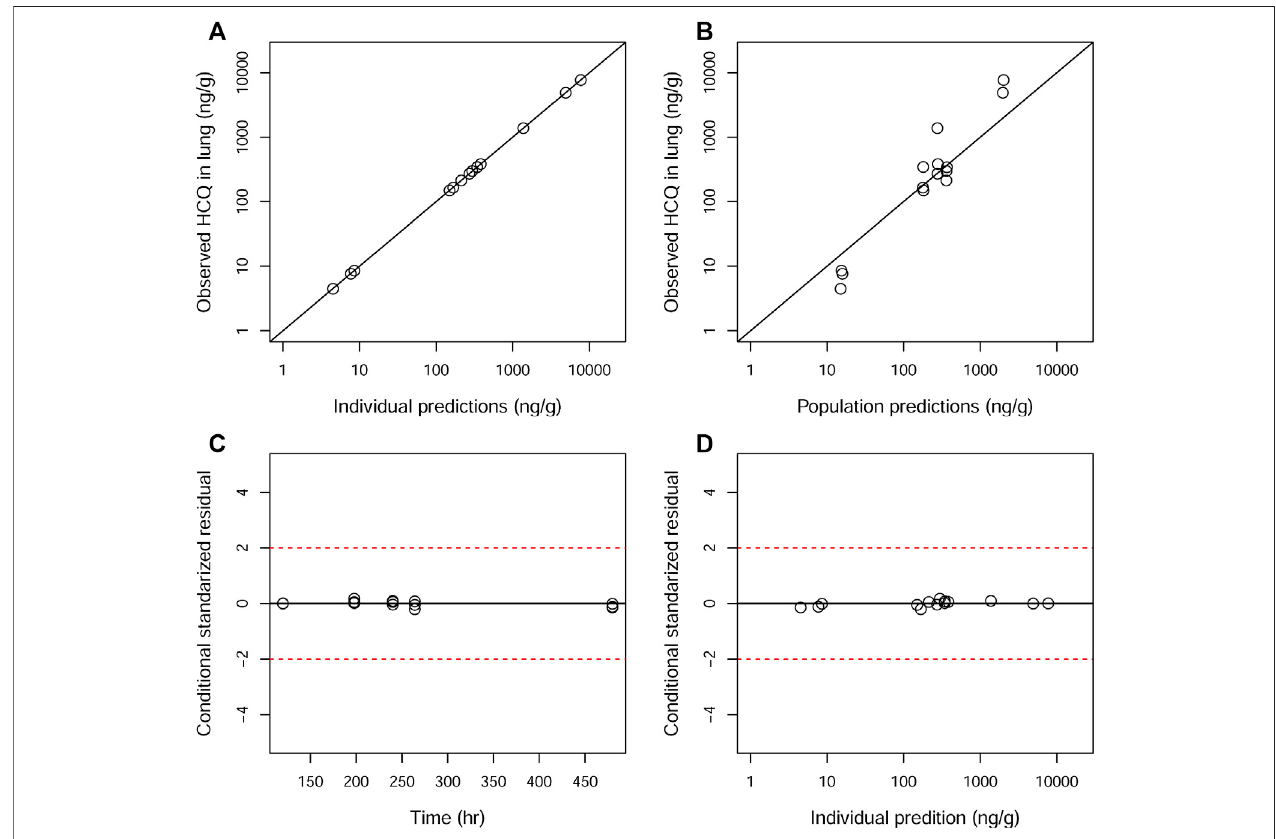
FIGURE5| Goodness-of- fi tplotsofthelungforthe fi nalmodel.Thehollowcirclesrepresenttheobserveddatafromindividualmonkeys.Theblackdiagonal (Aand B) and horizontal lines (C and D) are the lines of identity and zero lines, respectively. The dashed lines in the bottom panel are the conditional standardized residual equal ±